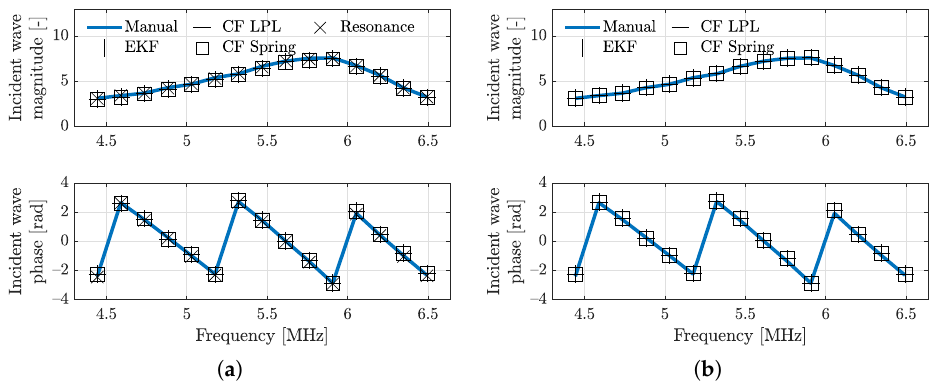
Figure 7. Incident wave spectrum estimate ( a ) Test 1. ( b ) Test 2. (notably, only every third point is shown for clarity in the figure).